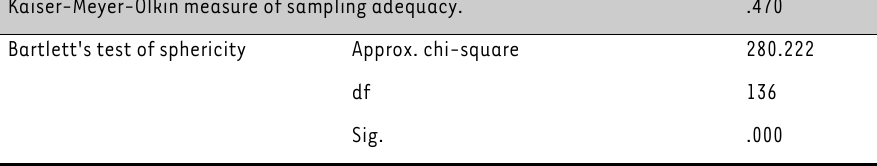
KMO and Bartlett's tests Kaiser-Meyer-Olkin measure of sampling